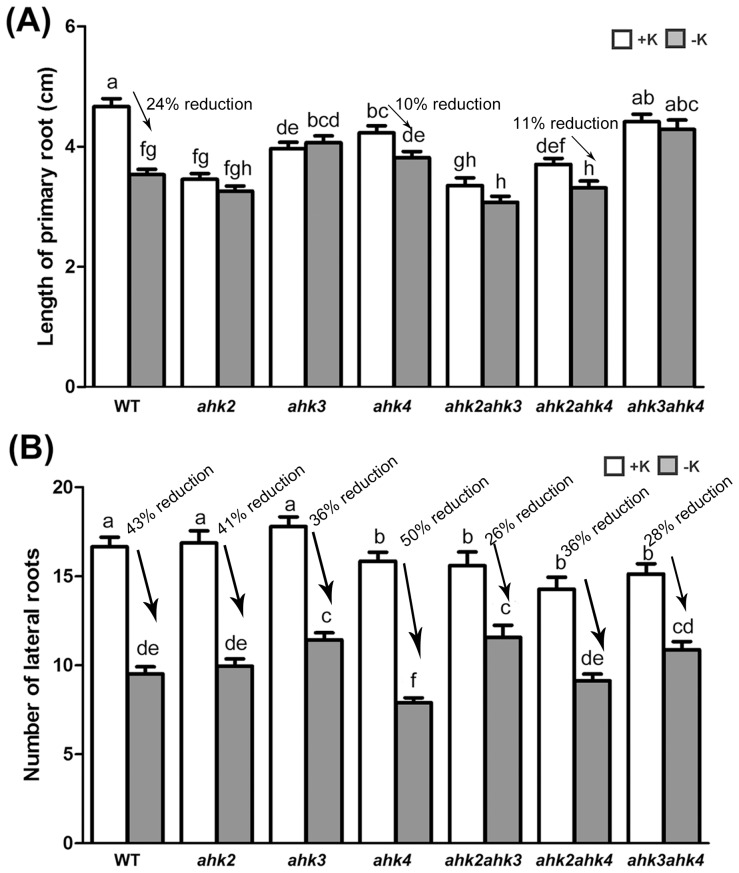
Root growth assay of WT and ahk mutants under +K and −K conditions.Plants were grown under +K conditions for 4 days and then transferred and grown on +K or −K medium for 7 days. Length of primary root (A) and number of lateral roots (B) were analyzed (n>30). Different letters indicate significant differences from each other as determined using ANOVA (P<0.05) and significances were corrected post hoc using Tukey’s HSD comparisons.